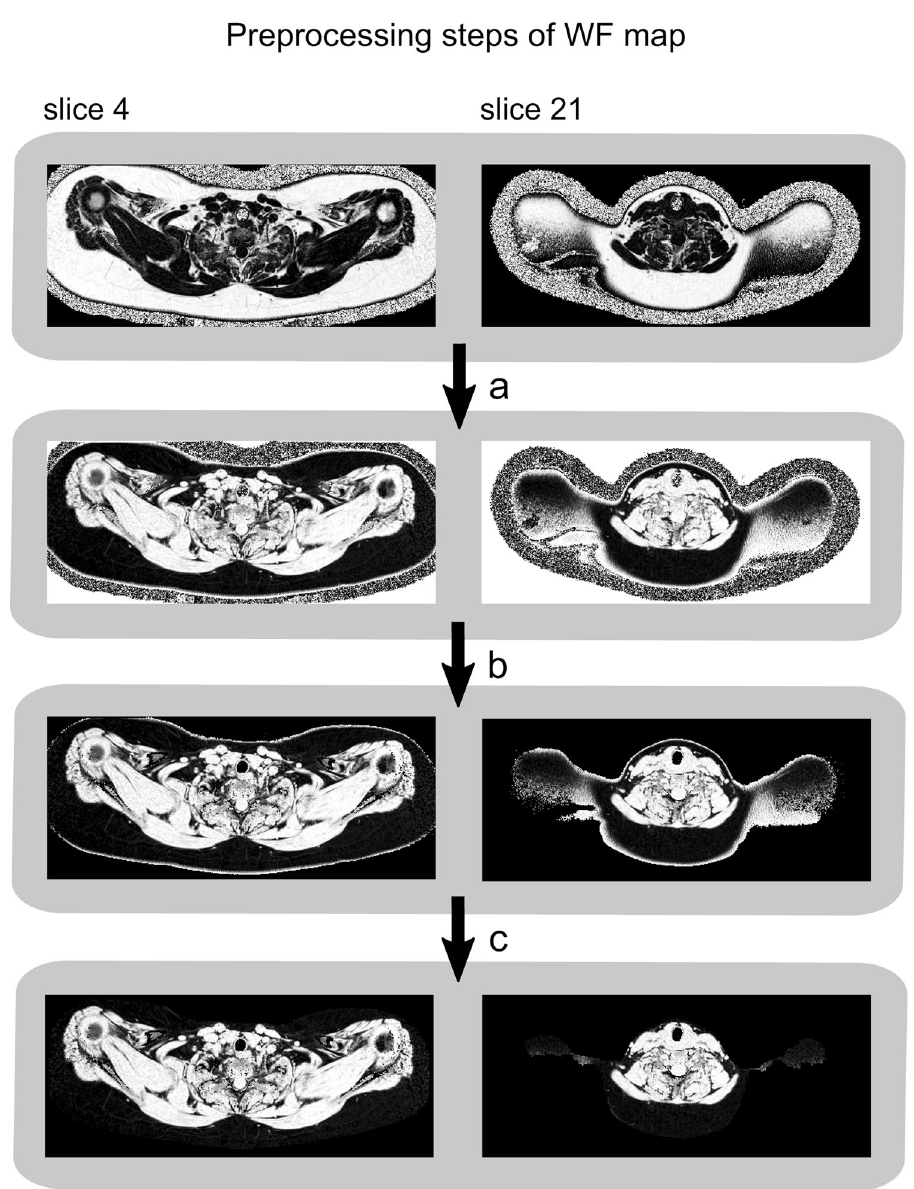
Figure 4. The preprocessing steps applied to the water fraction (WF) map prior to image registration in the multi-atlas segmentation (MAS) method. Two slices of the same subject are illustrated. Step a: Calculation of the WF map from the fat fraction (FF) map. Step b: Removal of background voxels. Step c: Removal of skin voxels. After preprocessing, the WF map consisted of an apparent lean tissue body. As the preprocessed WF map nearly surrounded the cervical-supraclavicular (sBAT) depot and exhibited relatively low inter-subject variability, it was suitable for registration